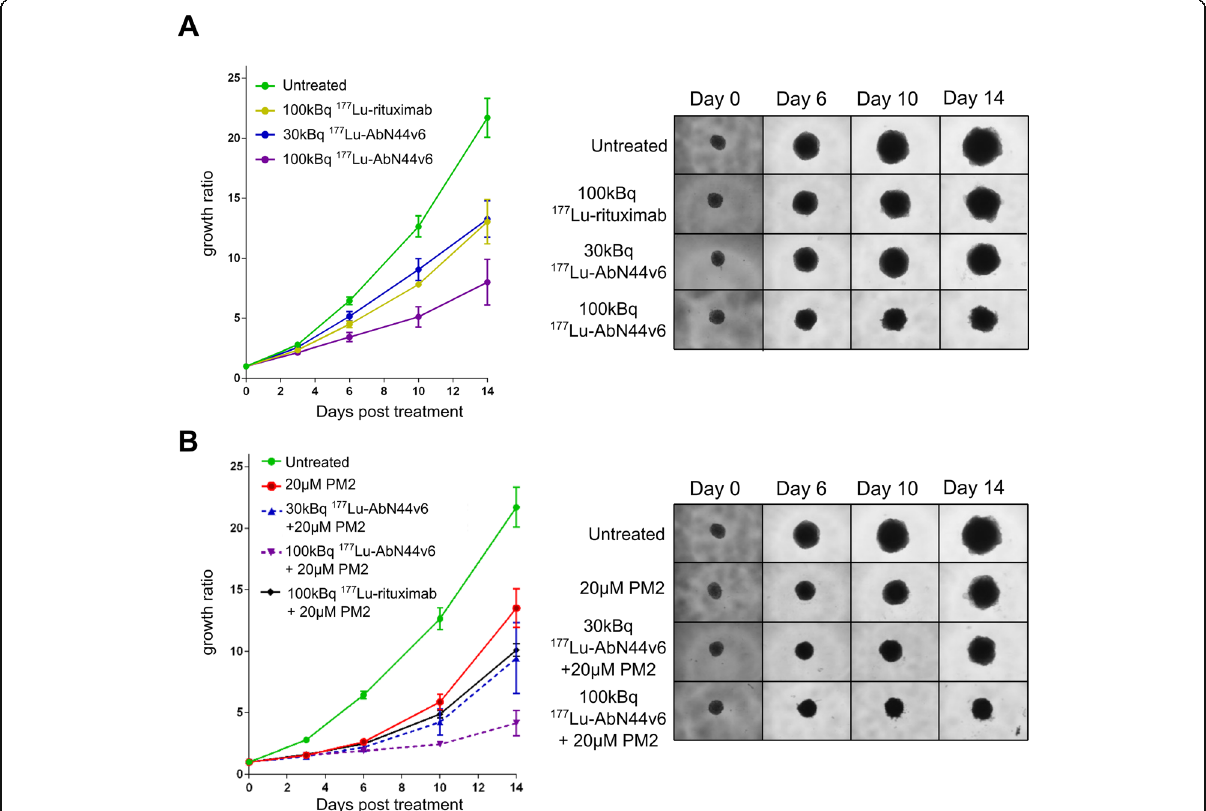
Fig. 3 a HCT116 spheroid growth over time after treatment with 30 kBq and 100 kBq 177 Lu-AbN44v6 and 100 kBq 177 Lu-rituximab as well as representative images of treated spheroids. b HCT116 spheroid growth over time after treatment with 20 μ M of PM2 and the combination of 20 μ M PM2 with 30 kBq and 100 kBq 177 Lu-AbN44v6 and 100 kBq 177 Lu-rituximab as well as representative images of treated spheroids. n ≥ 4, error bars presented as 95% confidence intervals. A combination of 20 μ M PM2 with 30 kBq 177 Lu-AbN44v6 differed significantly from monotherapies ( p < 0.01 and p < 0.05 for PM2 and TRNT, respectively). A combination of 20 μ M PM2 with 100 kBq 177 Lu-AbN44v6 differed